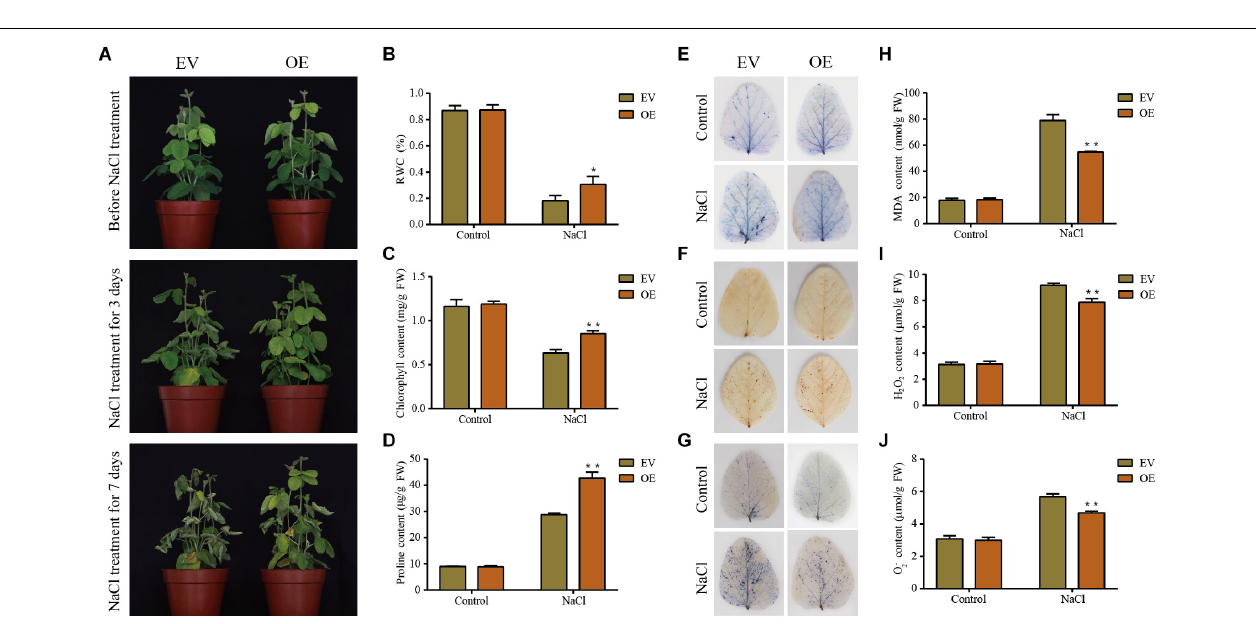
FIGURE 9 | Phenotypic and physiological analyses of the transgenic empty vector (EV) lines and GmDUF4228-70 -OE (OE) transgenic lines under salt stress. (A) Phenotypes of EV and GmDUF4228-70 -OE transgenic soybean plants treated under salt stress for 3 and 7 days, respectively. Relative water content (RWC) (B) , chlorophyll content (C) , proline content (D) , trypan blue staining (E) , DAB staining (F) , NBT staining (G) , malondialdehyde (MDA) content (H) , H 2 O 2 content (I) , and O 2 - content (J) of the leaves of EV and GmDUF4228-70 -OE plants grown under salt treatment or normal control conditions for 3 days. Data are shown as mean ± standard deviation ( n = 3). Significant differences based on ANOVA are set at p < 0.05 (*) and p < 0.01 (**), respectively.